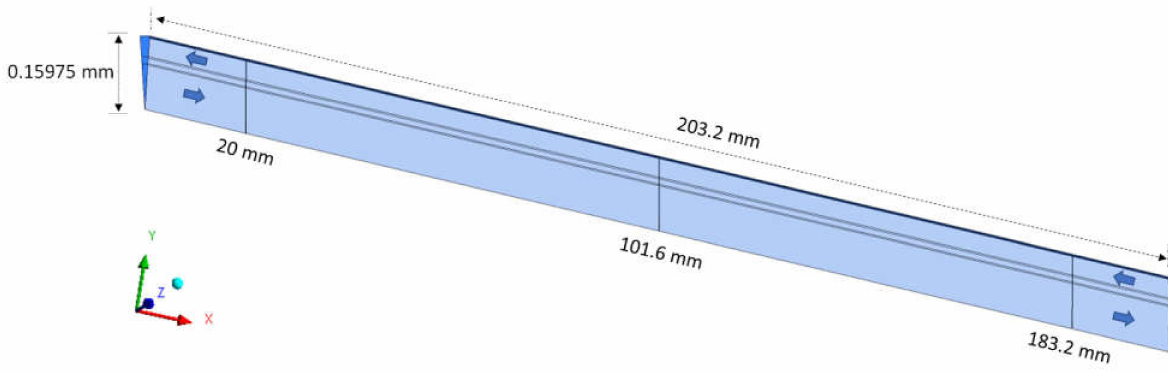
Figure 6. Axial positions of lines for collecting urea velocity